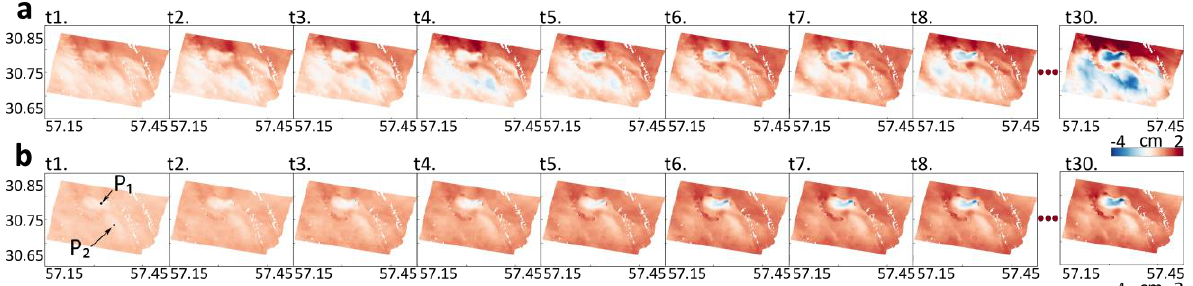
Figure 3. a: Time series maps resulted from the original interferograms correspond to 30 dates that span 1 year after the earthquake. b: Time series maps calculated by reconstructed interferograms.